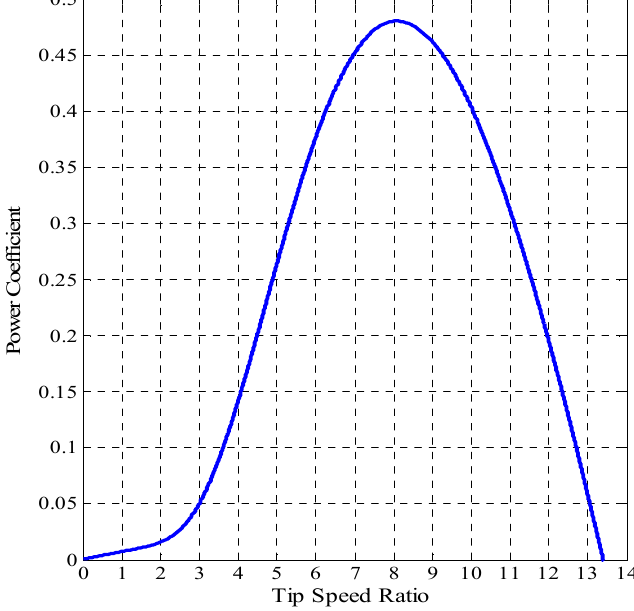
Figure 2. The relation between power coefficient ( C